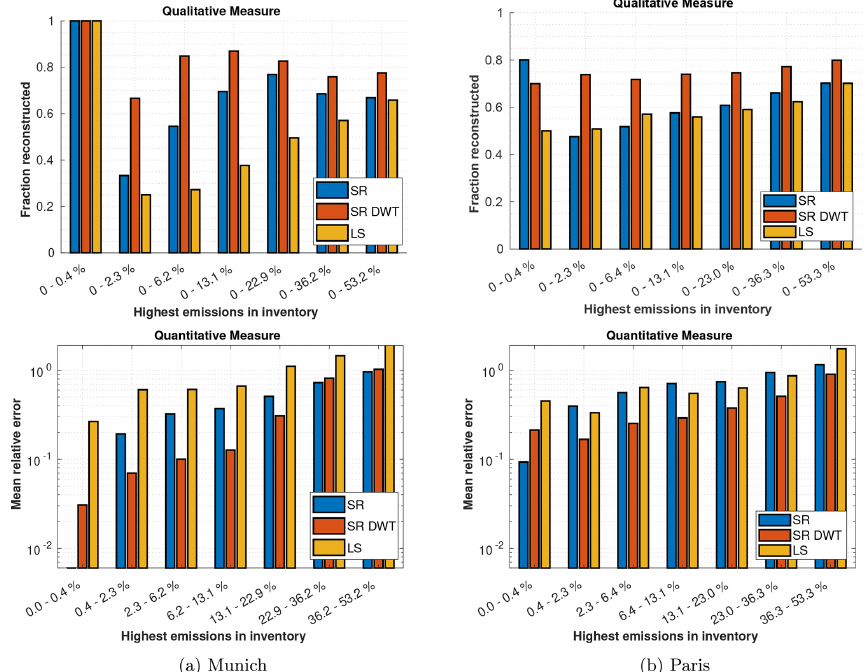
Figure D1. Qualitative and quantitative measure of how well SR and LS estimate the highest emitters for Munich (a) and Paris (b) using m ≈ n